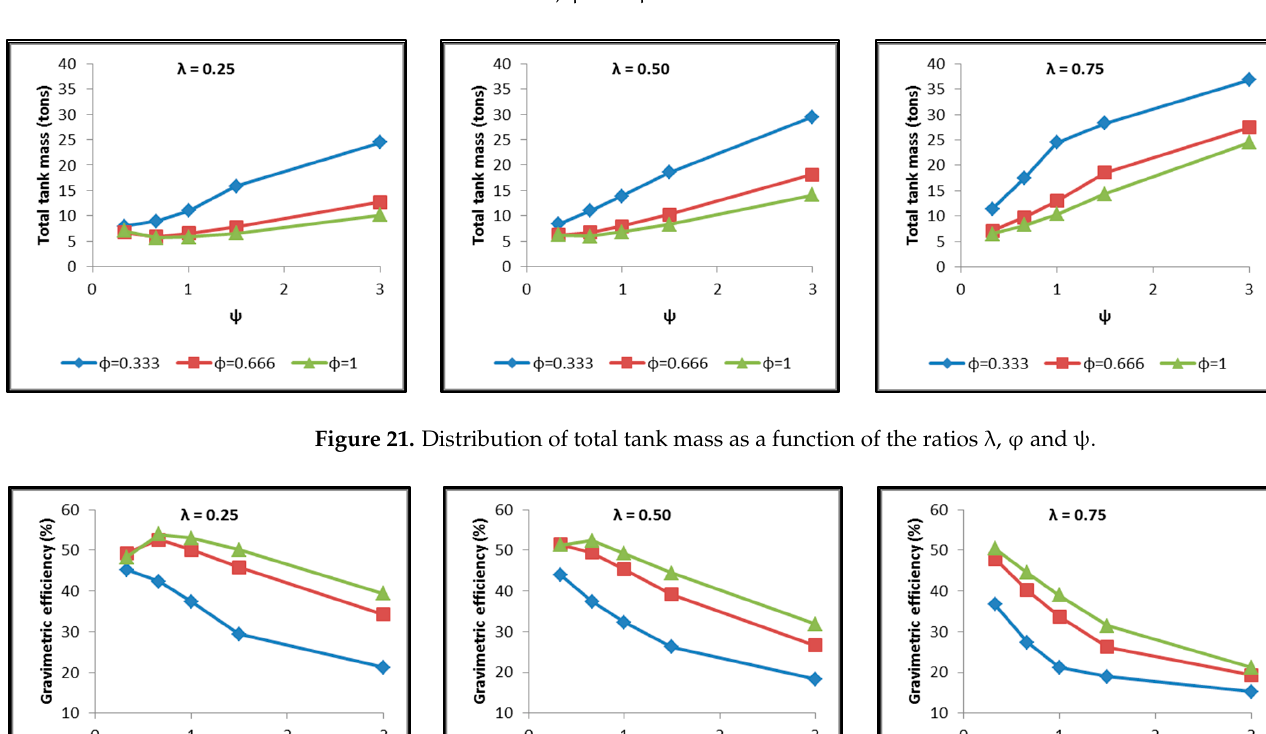
Figure 20. Distribution of inner aluminum shell thickness for evaluation of the Von Mises criterion as a function of the ratios λ , φ and ψ .